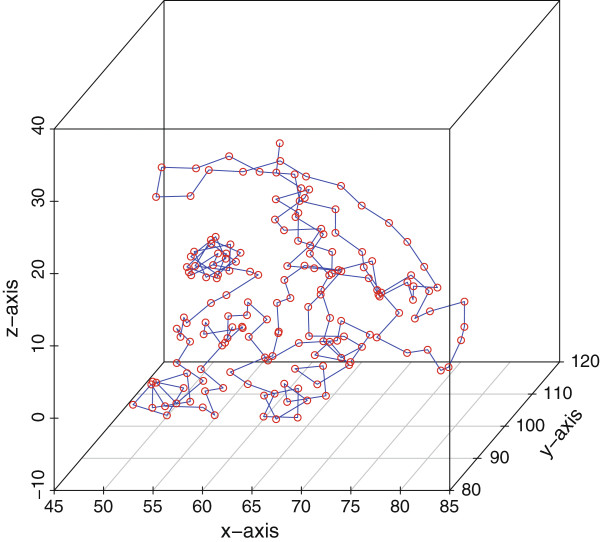
KRASα-carbons in 3D Space.